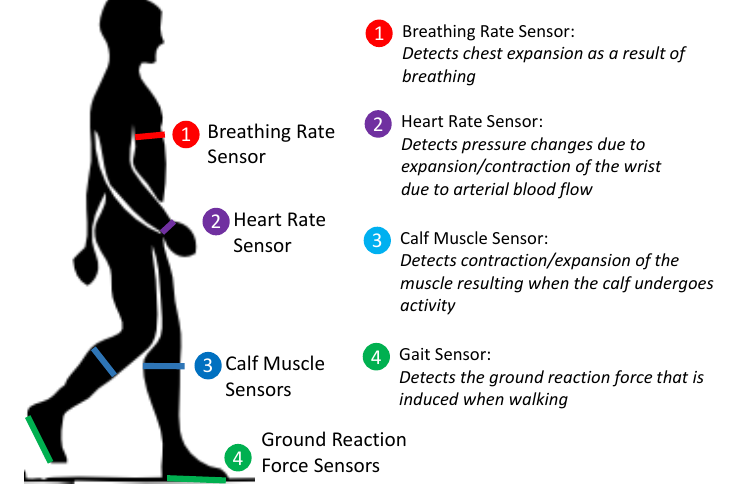
Figure 1. Summary of the different wearable sensors developed, and the locations they should be worn to enable different stimuli to be